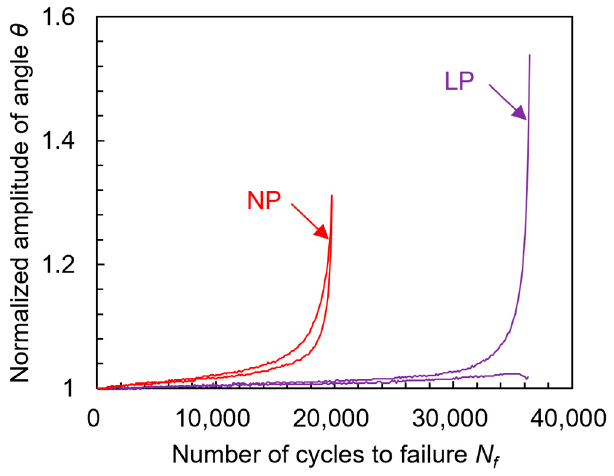
Figure 15. Torsion angle as function of number of cycles at τ a = 460 MPa.